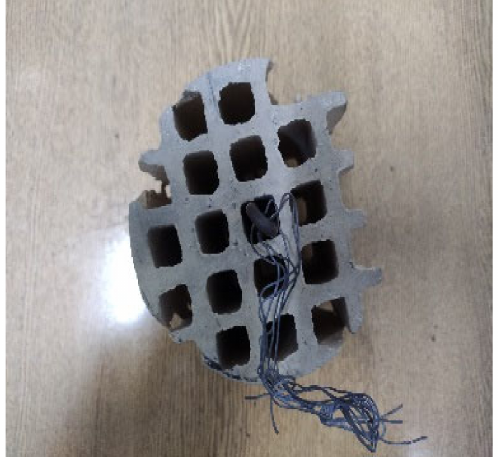
Figure 3. Platinum catalyst on the ceramic